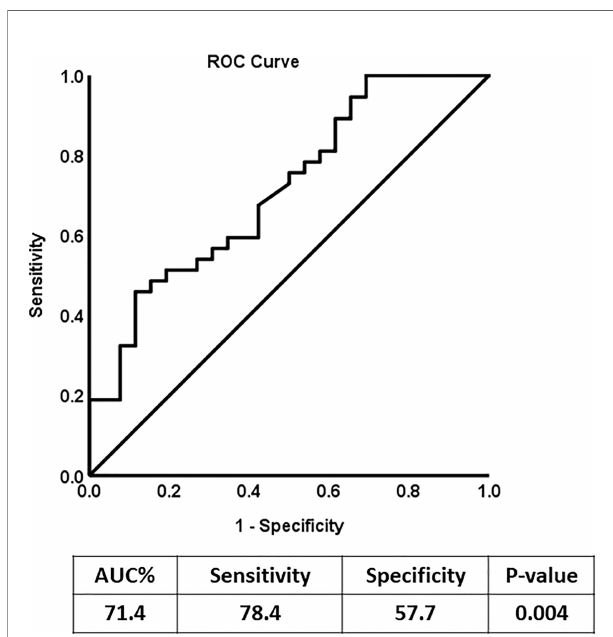
FIGURE 2 | Receiver Operating Characteristic (ROC) curve analysis for N- cadherin of DN Group compared to the non-diabetic control